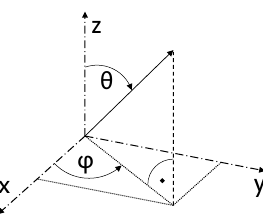
Figure 25. 1st eigenvector (displayed as arrow) of a fiber orientation in 3D space described by the polar angle θ and the azimuthal angle ϕ (Eulerian angles) in a Cartesian coordinate system. Table 6. Averaged fiber orientation measurement results for the rib analysis areas of three CT scanned ribbed hat